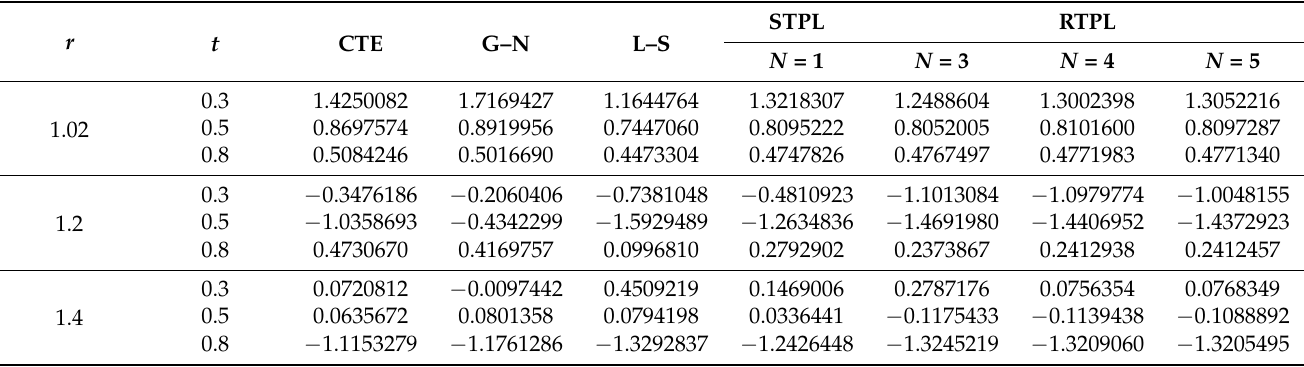
Table 4. Different thermoelasticity theories with a range of r values show the effects of dimensionless time t on radial stress σ rr